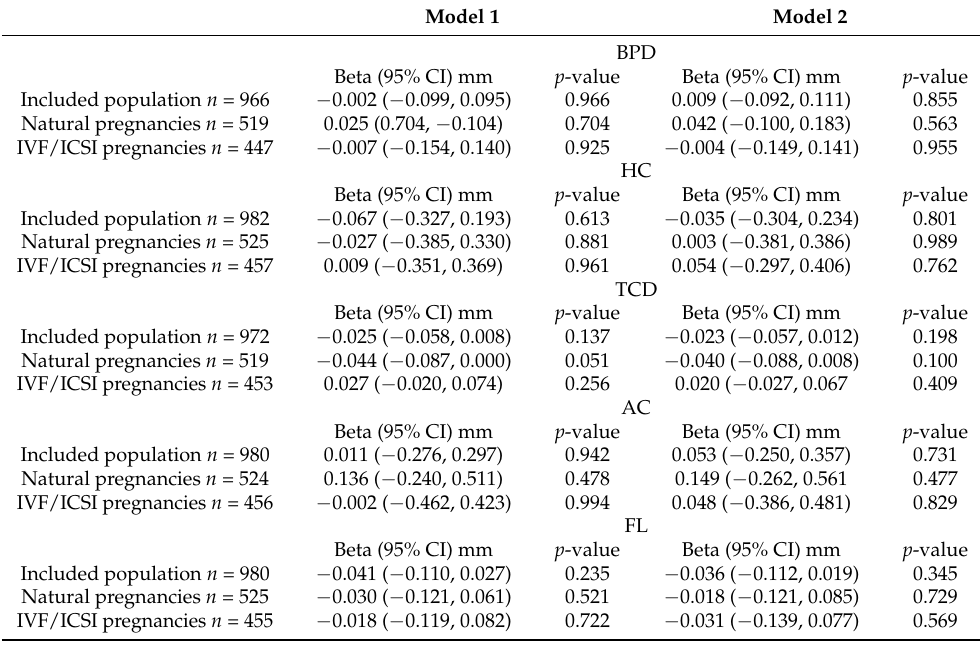
Table 3. Association between maternal homocysteine and fetal growth from the second trimester fetal anomaly scan in the included population ( n = 1060), natural pregnancies ( n = 555), and IVF/ICSI pregnancies ( n =